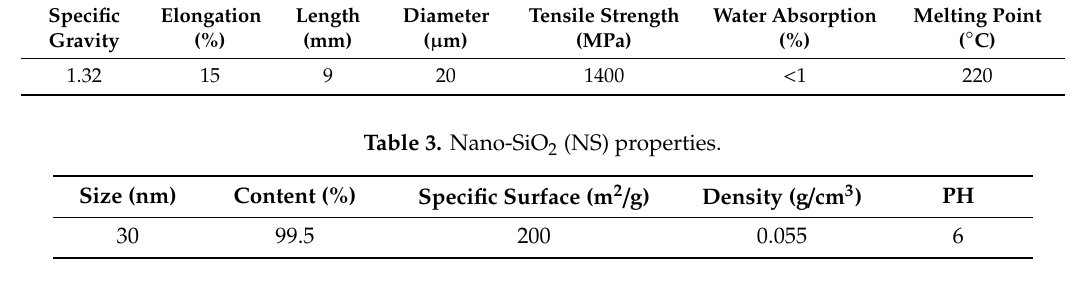
Table 4. High range water reducer (HRWR) properties.